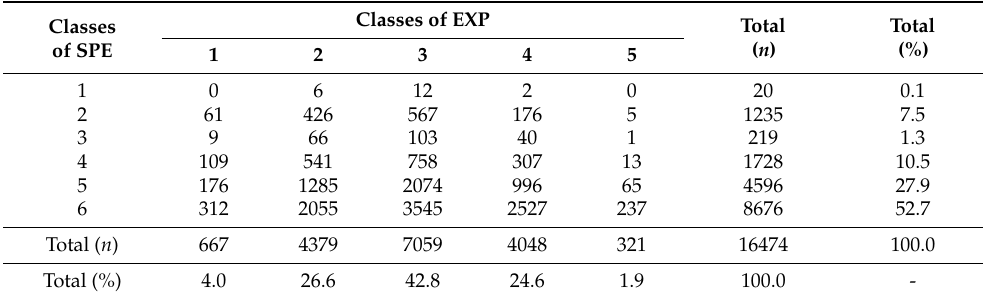
Table 8. The LAU’s number for each combination of the five EXP classes and six SPE classes for data of the first census date